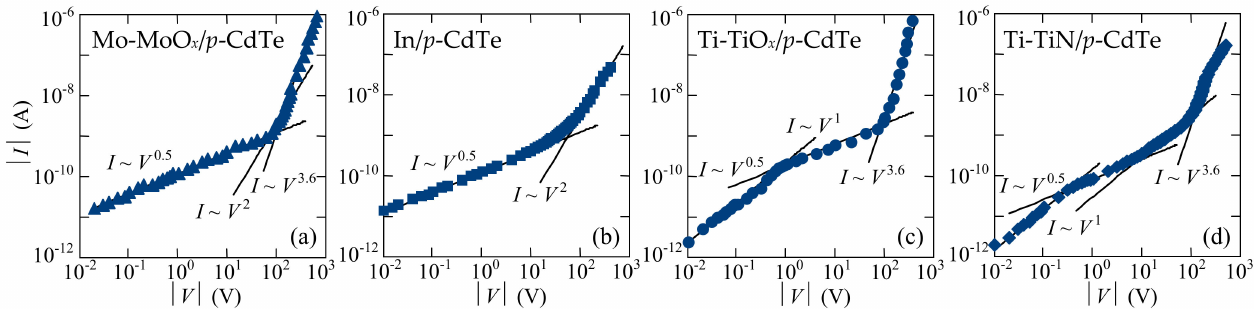
Figure 4. Reverse I-V characteristics of the ( a ) Mo-MoO x / p -CdTe/MoO x -Mo, ( b ) In/ p -CdTe/MoO x -Mo, ( c ) Ti-TiO x / p - CdTe/MoO x -Mo, and ( d ) Ti-TiN/ p -CdTe/MoO x -Mo Schottky-diode detectors in double logarithmic coordinates (symbols). Approximations of the square root ( I~V 0.5 ), linear ( I~V ), square-law ( I~V 2 ), and power-law ( I~V 3.6 ) voltage dependences of the current are shown by solid